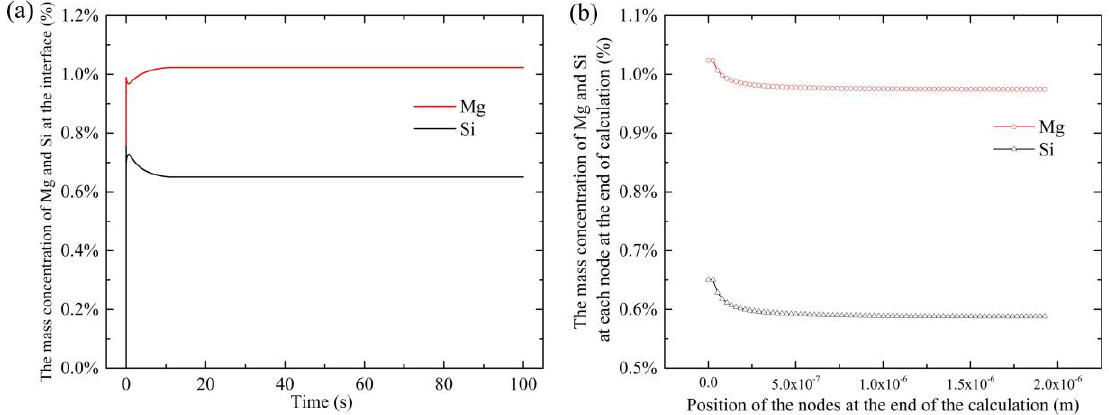
Figure 8. ( a ) Mass concentrations of Mg and Si on the boundary changed with time. ( b ) Mass concentrations of nodes at the end of the